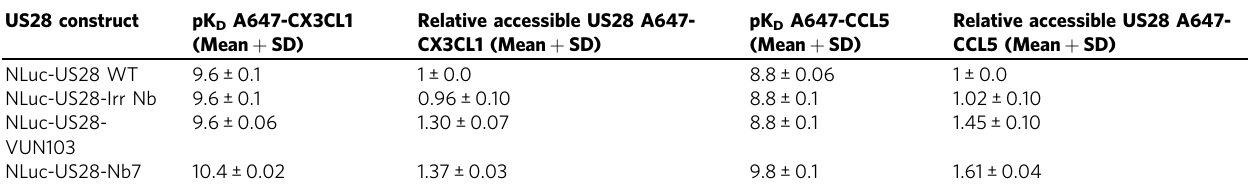
Table 2 pK D values and relative accessible US28 of A647-labeled CX3CL1 to different NLuc-US28-nanobody fusion constructs. US28 construct